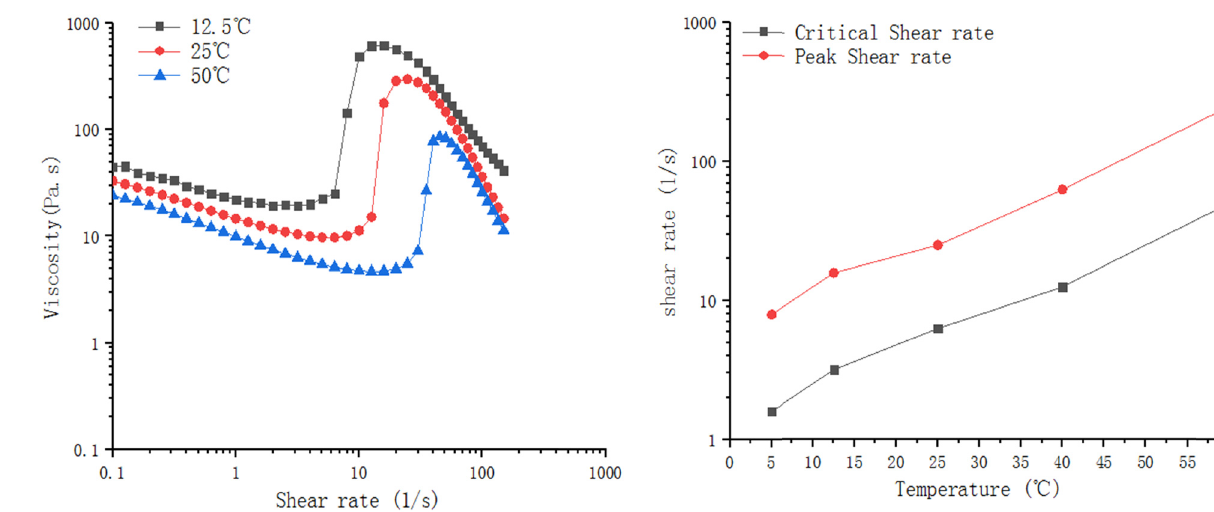
Figure 12: The shear rate of the 0.15% MWCNTs – PVP/SiO2 – STF system changes with temperature.